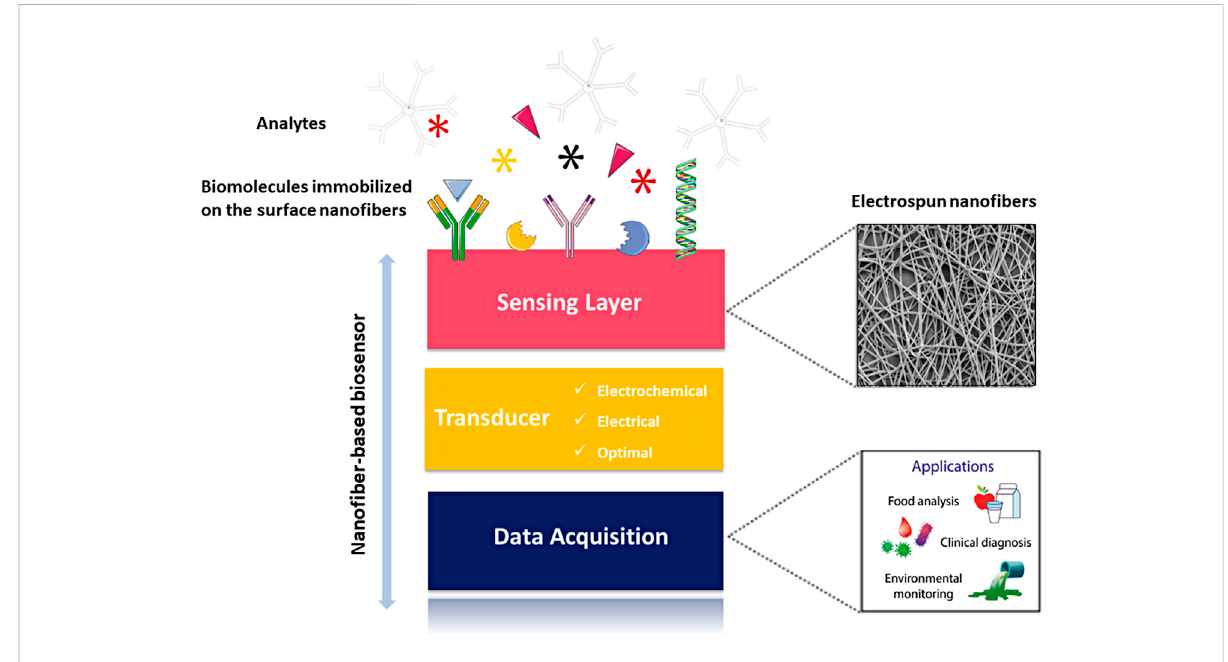
FIGURE 5 Schematic illustration of a nano fi ber-based biosensor